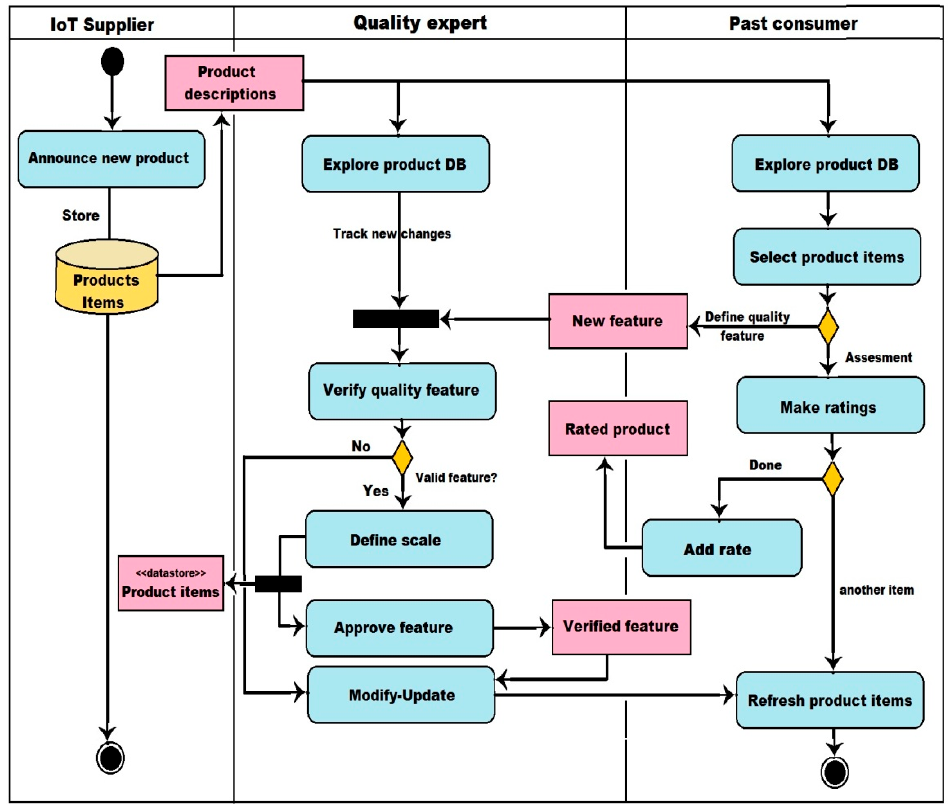
Figure 3. The main actors’ related activities.